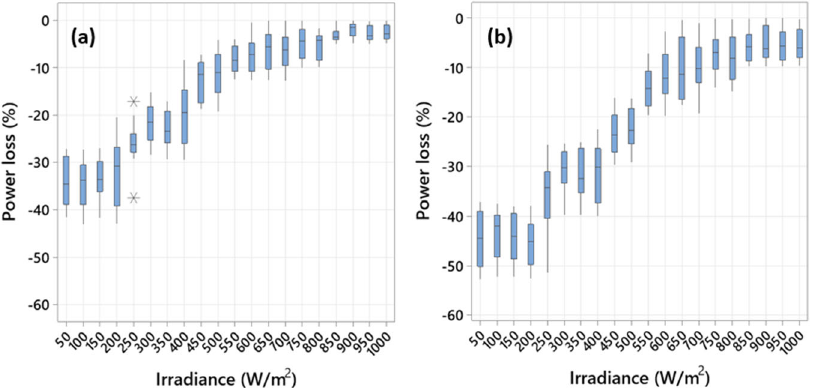
Fig. 3 Calculated power losses versus irradiance. a PID test at 48 h, b PID test at 96 h. The irradiance step change is 50 W/m 2 taken for the 24 tested PV modules, and the temperature is maintained at 25 °C. The error bars represent the average collected data of the 28 tested PV